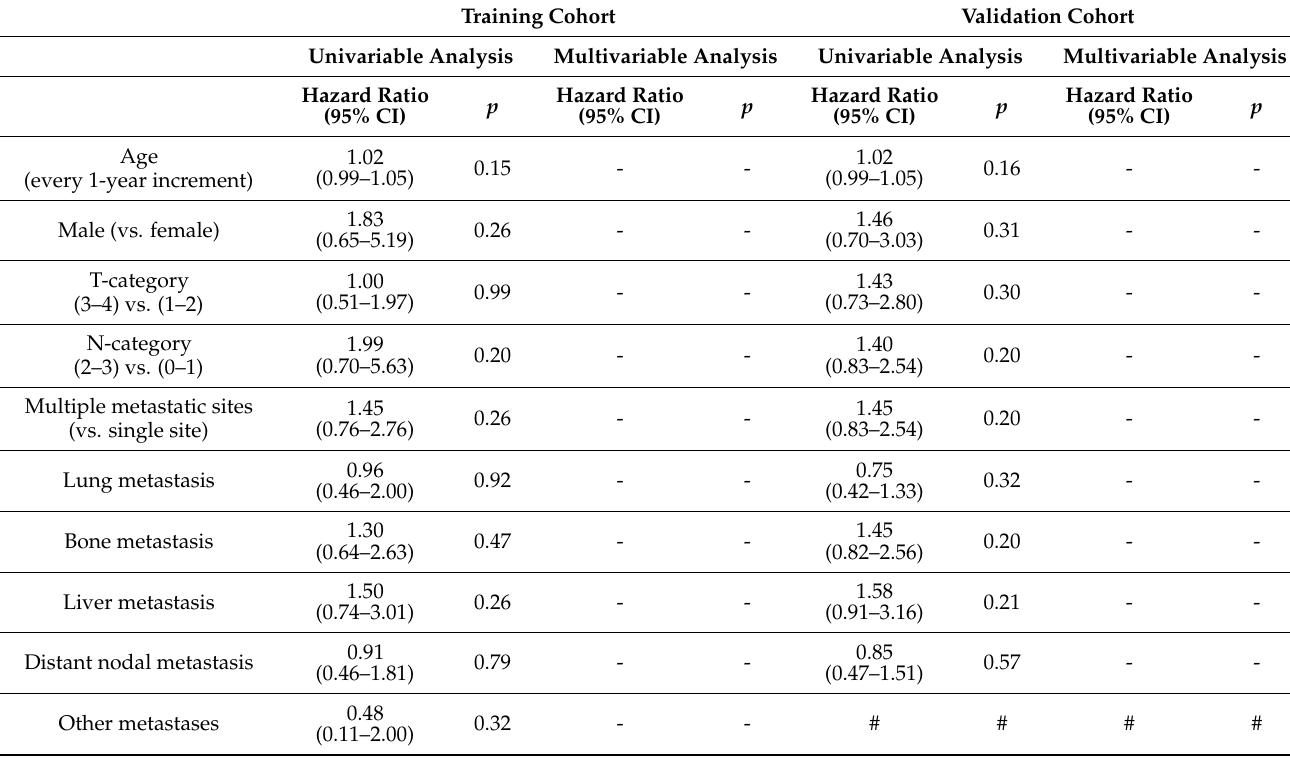
Table 2. First-round univariable and multivariable analyses of demographic and anatomic variables prognostic of overall